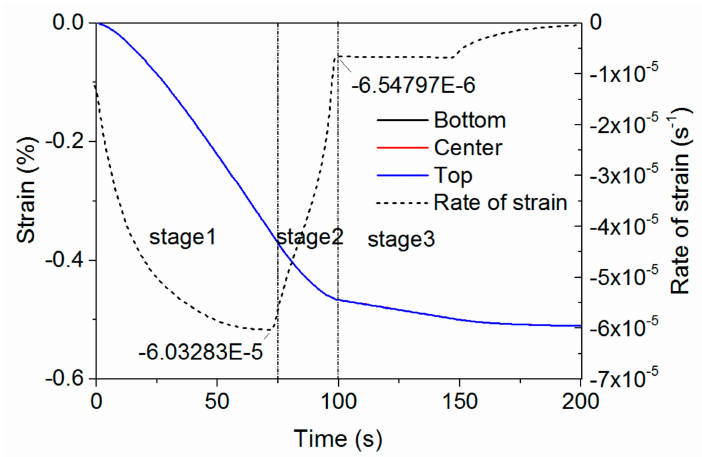
Figure 9. Thermally-induced strain and corresponding rate of